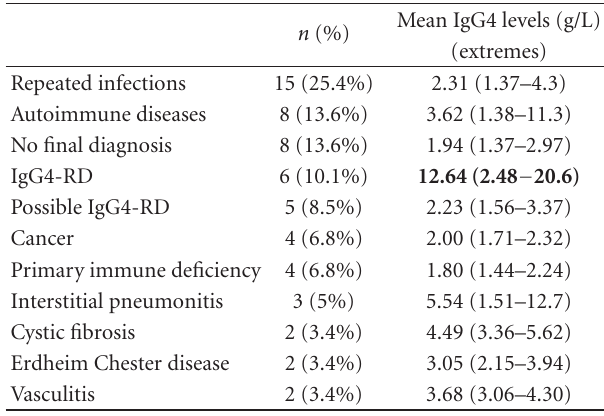
Table 2: Final diagnosis in patients with elevated serum IgG4 level ( >